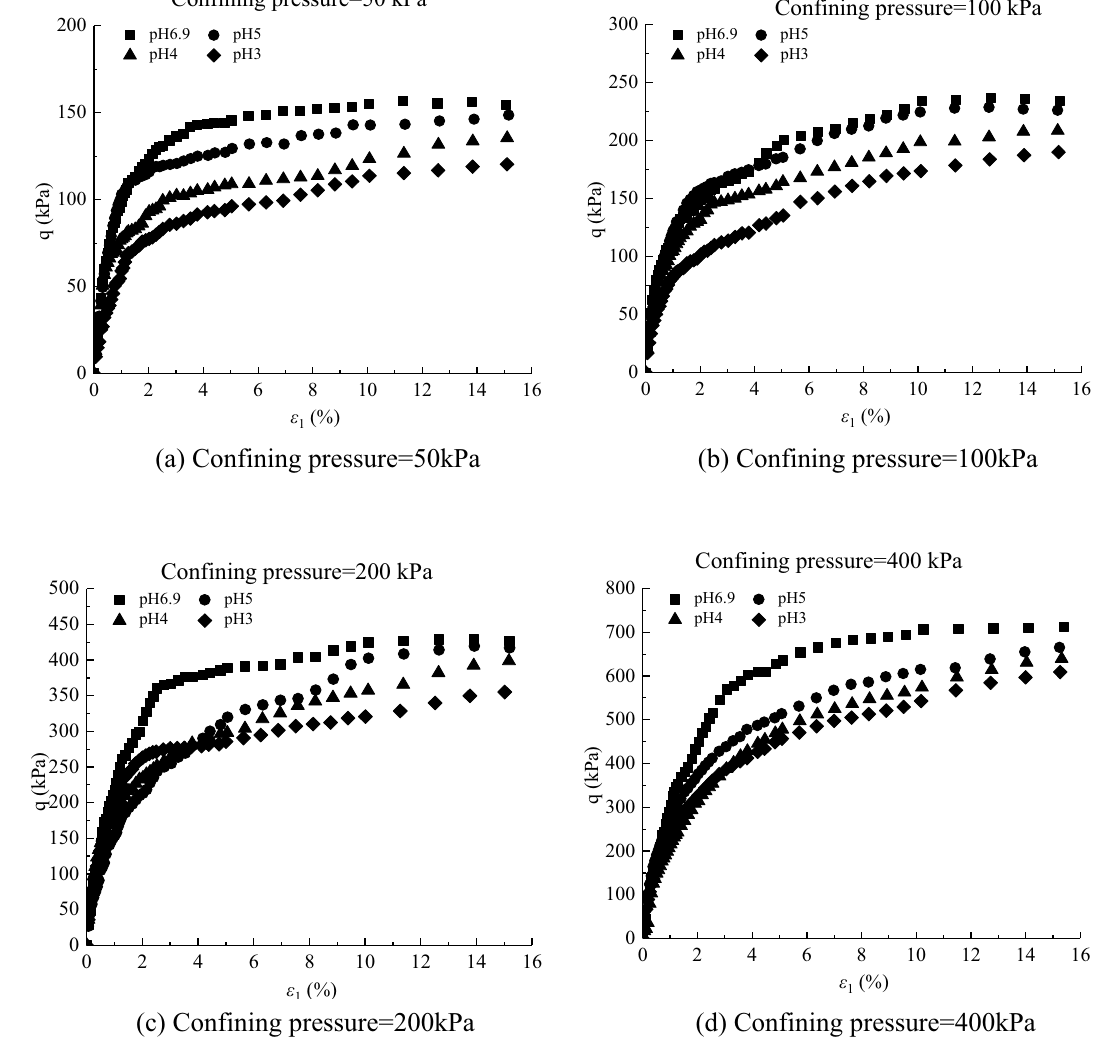
Figure 4. Experimental results of deviatoric stress–axial strain curves of loess samples under different values of